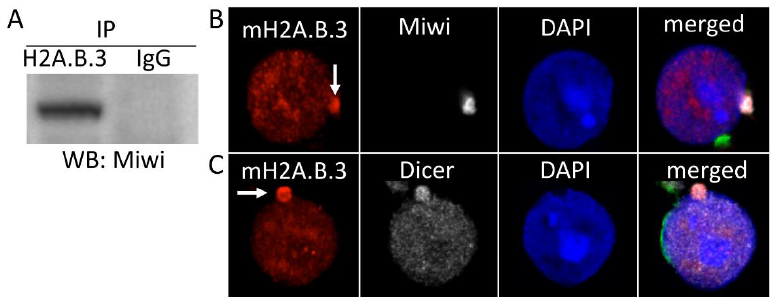
Figure 3. H2A.B.3 co-localises with Miwi and Dicer in chromatoid bodies of rounds spermatids and co-immunoprecipitates with Miwi protein. ( A ) H2A.B.3 co-immunoprecipitates with Miwi (Cell Signalling cat# 2079S) in non-crosslinked total testis lysates following the procedure described previously [14]. Non-targeting IgG control was used as a negative control during immunoprecipitation. ( B , C ) Hypotonic spreads of male germ cells [14] showing round spermatids indirectly immunostained with antibodies against mouse H2A.B.3 (red), lectin PNA (green), Miwi ( B ) (white) or Dicer ( C ) (white) (abcam cat# 13502) and counterstained with DAPI (blue) to visualize DNA. White arrows show the location of chromatoid bodies.